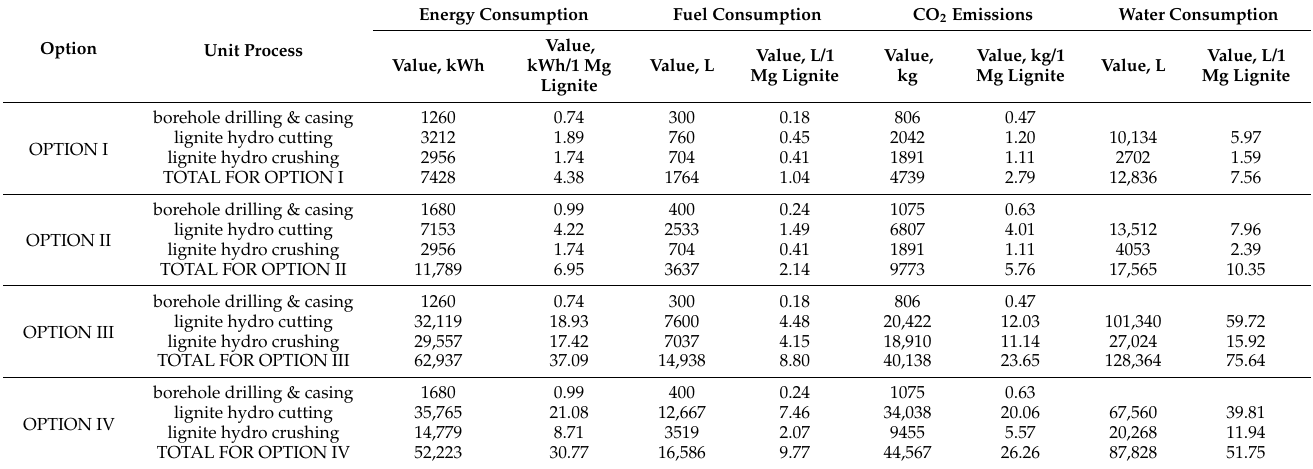
Table 5. Energy, fuel and water consumption and CO 2 emissions for the four options results.